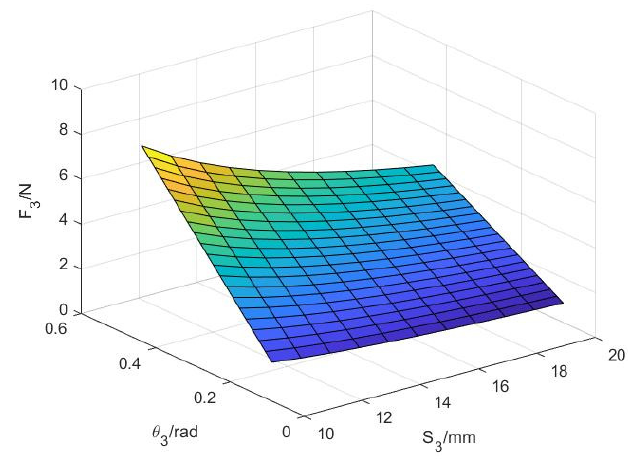
Figure 8. The functional relationship between variables S 3 , θ 3 , and F 3 . As shown in Figure 8, the contact force F 3 at the distal finger increases with the increase in the guide bar angle θ 3 . In addition, the smaller the position S 3 of the contact point on the distal finger, the greater the contact force on the distal finger. In other words, the closer the object is to the palm, the greater the contact force; this conforms to the situation of grasping objects by hand, indicating that the design is feasible. Similarly, according to (27), the variation relationship between the second knuckle F 2 , angle θ 2 , and angle θ 3 can be obtained, as shown in Figure 9.